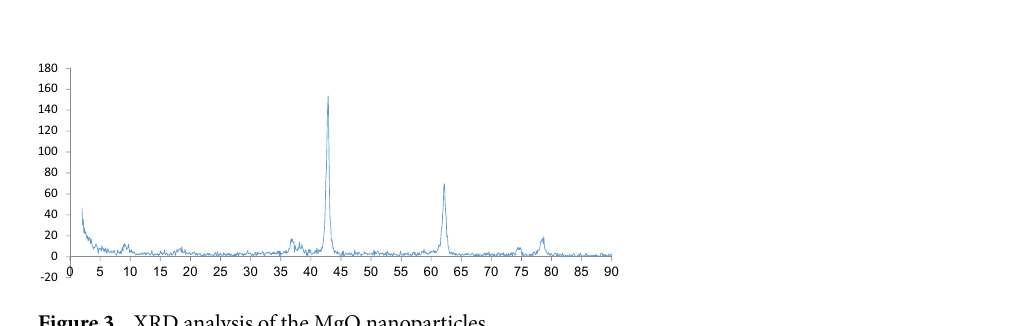
Figure 3. XRD analysis of the MgO